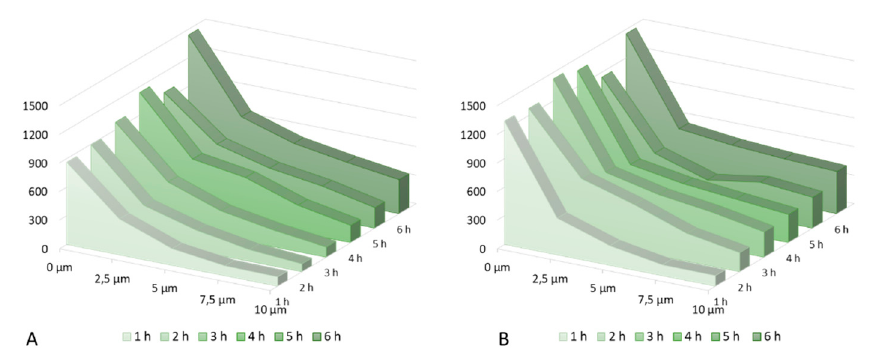
Figure 5. Figure 5. ( A ): Caffeine penetration over 6 h incubation time (2% caffeine solution); ( B ): Caffeine